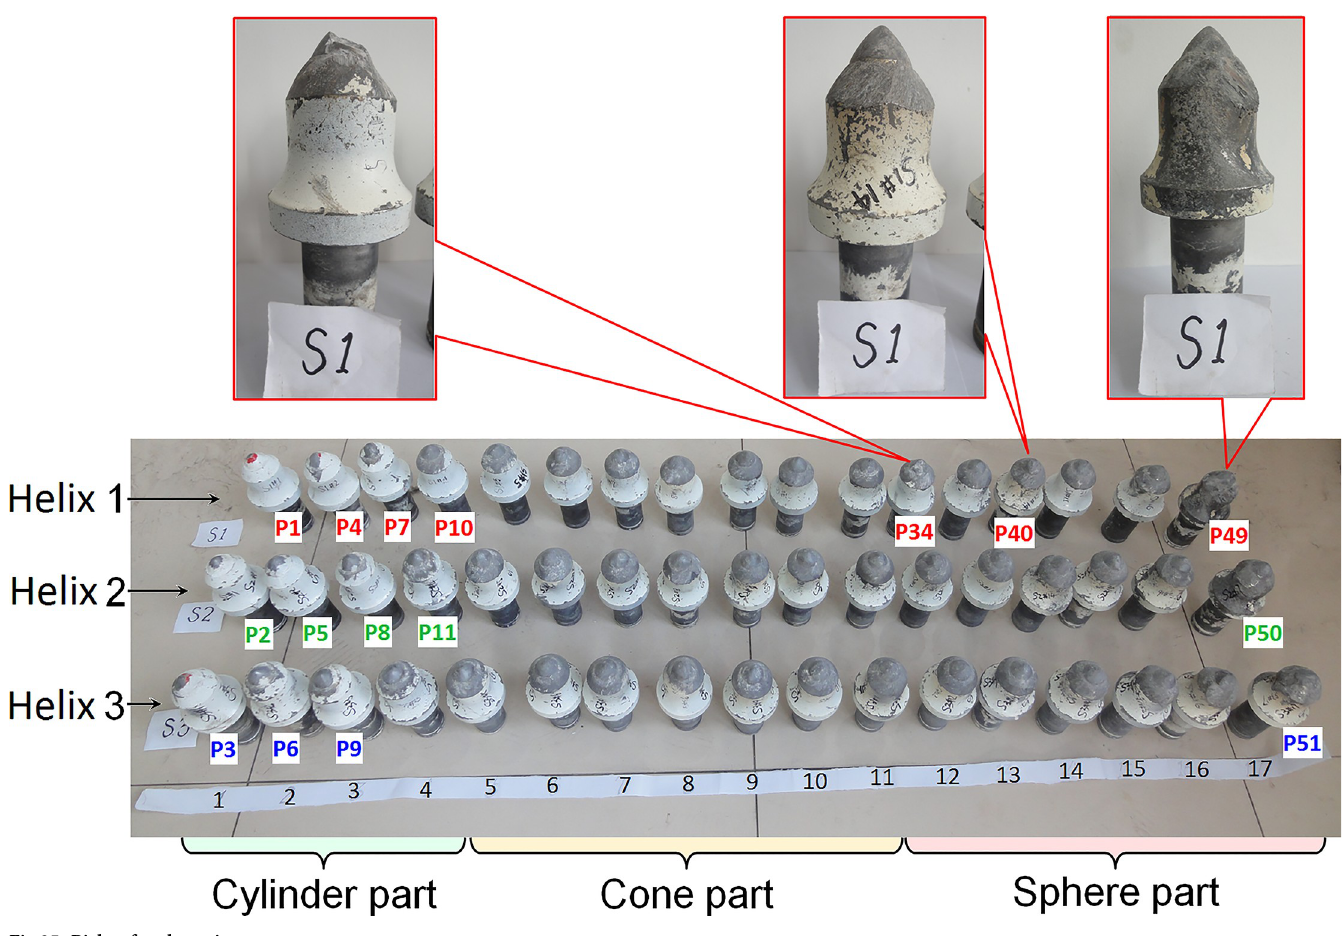
Fig 25. Picks of rock cutting